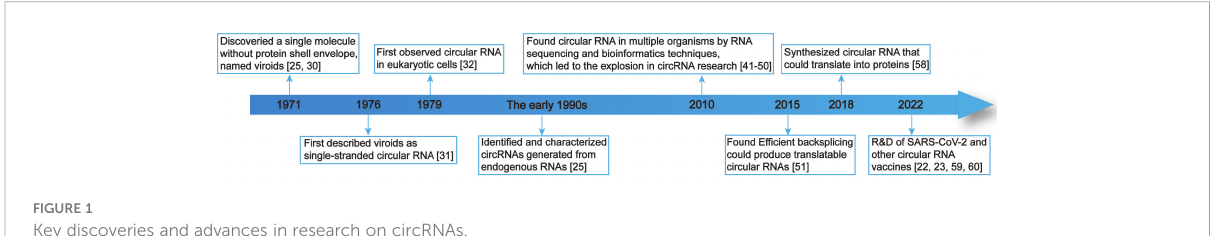
FIGURE 1 Key discoveries and advances in research on